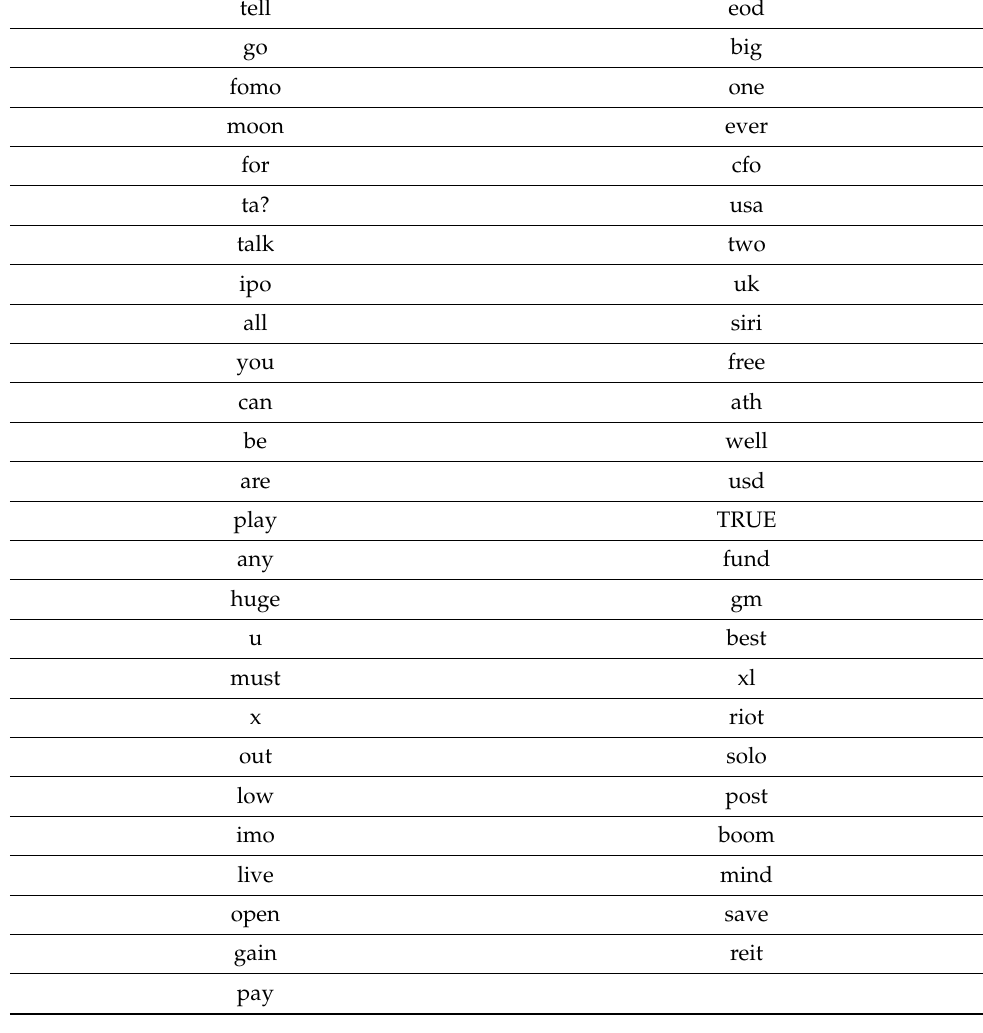
Table A1. Table containing tickers similar to words in the English language, removed from the tickers list.